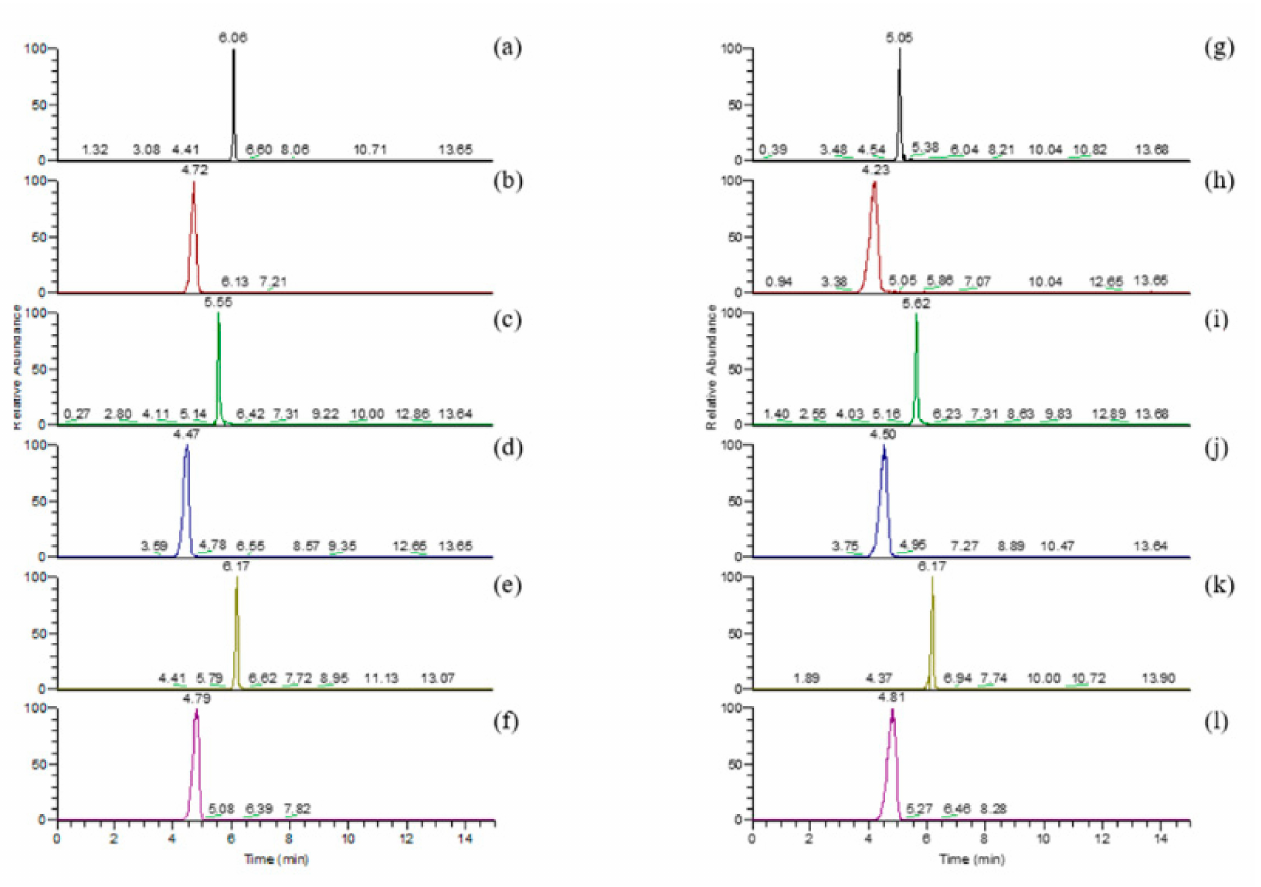
Figure 3. LC-MS chromatogram of anthocyanin standard. ( a ) Pelargonidin, ( b ) pelargonidin-3-glu, ( c ) Cyanidin, ( d ) Cyanidin-3-glu, ( e ) peonidin, ( f ) peonidin-3-glu. ( g ) delphinidin, ( h ) delphinidin-3- glu, ( i ) petunidin, ( j ) petunidin-3-glu, ( k ) malvidin, ( l ) malvidin-3-glu. Table 3. Composition and content of anthocyanins in barley of different colors ( µ g/g). Types Black